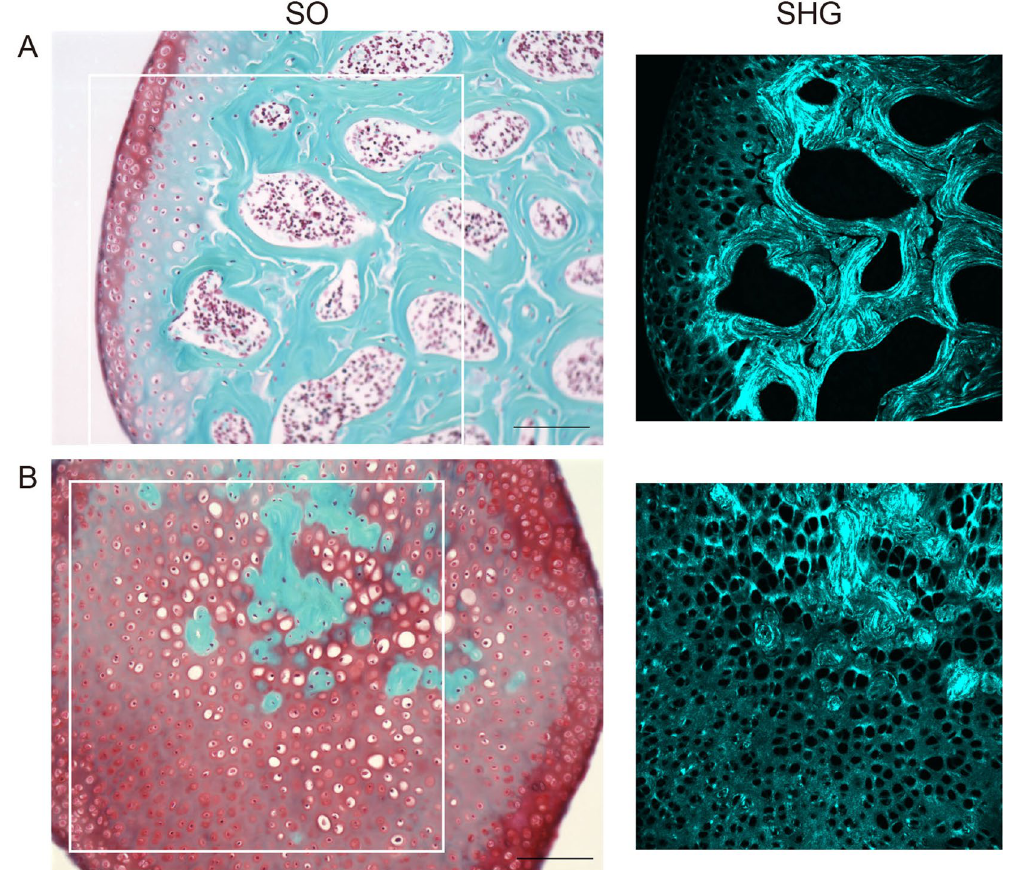
Figure 1. Histological and SHG images of frontal sections from the normal medial condyle in the distal femur. Left: Bright-field images of the SO-stained sections. Right: SHG images corresponding to the white frames in the SO (left) images. These are representative images that captured the subchondral bone ( A ) and cartilage ( B ). Scale bar: 100 μ